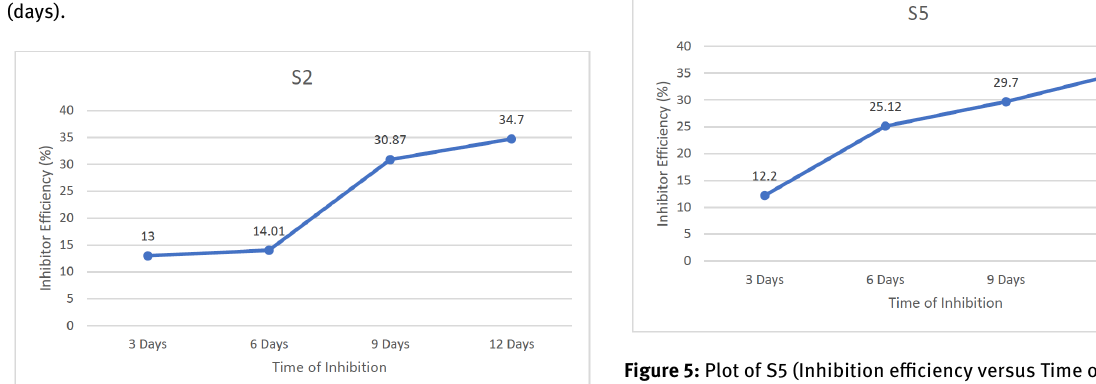
Figure 5: Plot of S5 (Inhibition eflciency versus Time of inhibition